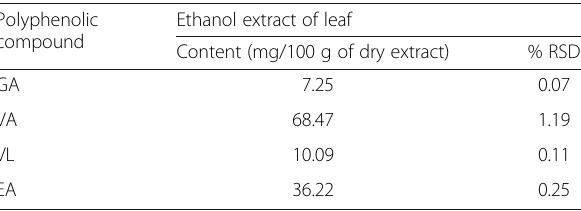
Table 3 Effect of extracts in acetic acid induced writhing in mice Treatment